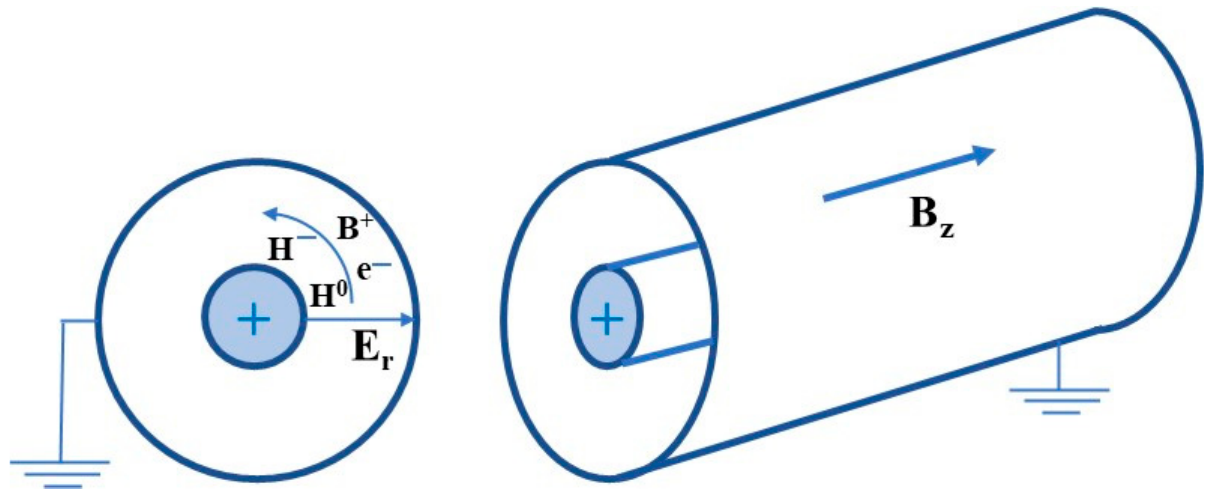
Figure 2. Rotation chamber configuration with coaxial cylinders and axial magnetic field B z . With outer wall grounded, the positively biased center electrode produces a radial electric field E r . The ExB forces drive the positive and negative ions and the electrons in a counterclockwise motion. The plasma oscillations of H − and B+ occur in the gap between two cylinders.